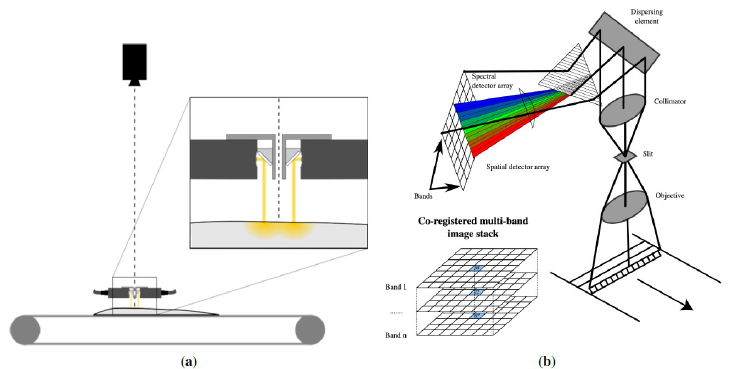
Figure 3. ( a ) The HSI setup with the Hyperspectral camera. c (cid:13) NOFIMA, Norway. ( b ) The HSI linear push-broom array. c (cid:13)